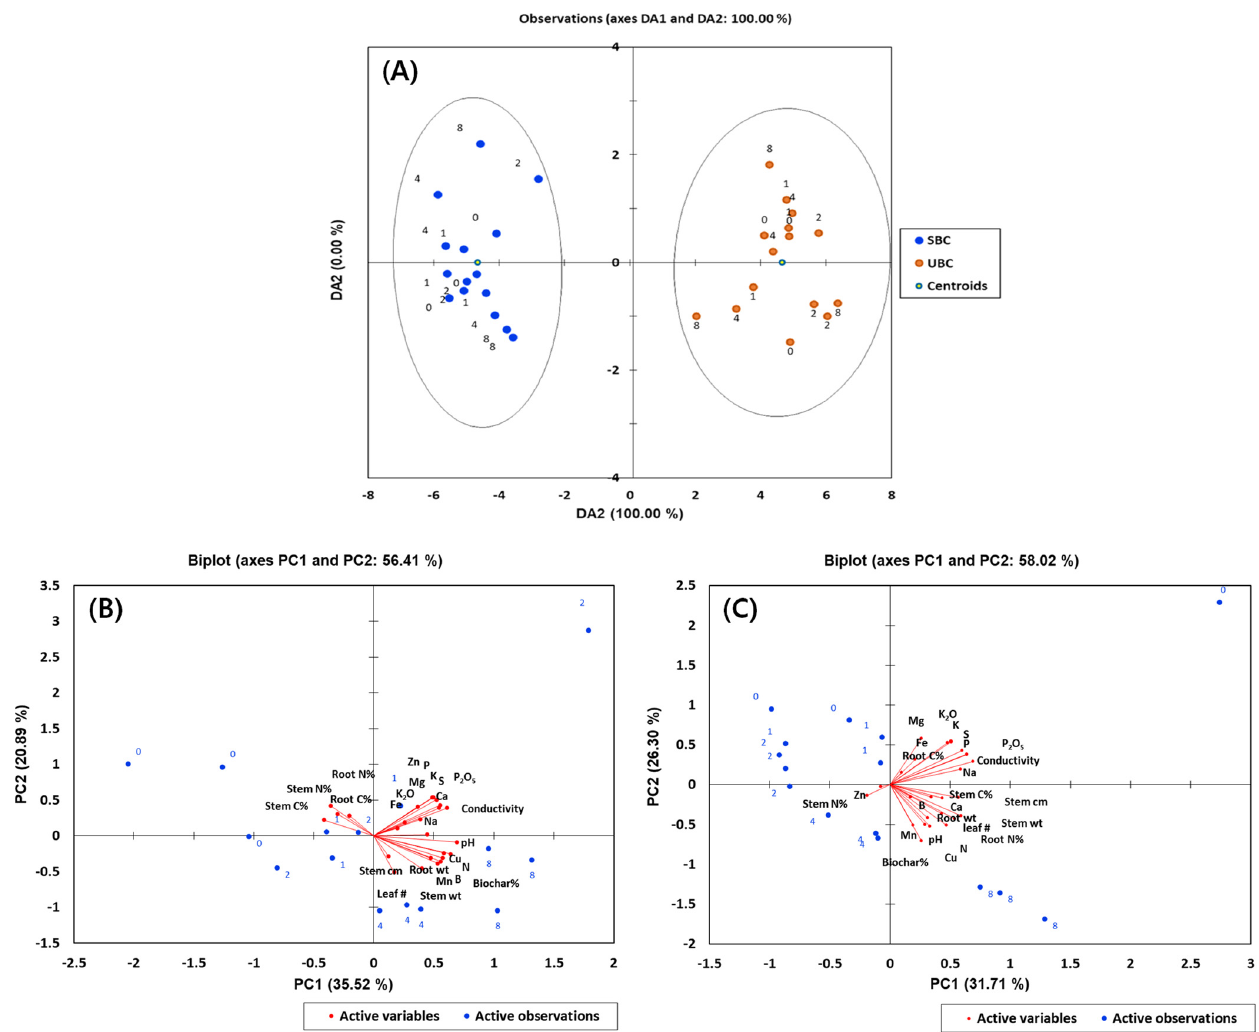
Figure 1. Physicochemical properties of wood biochar (BC) treated soil. Discriminant analysis (DA) among soil treated with SBC and UBC ( A ). Principal component analysis (PCA) of soil properties, plant growth parameters and the loading rates of saturated BC (SBC) in soil ( B ) and unsaturated biochar (UBC) in soil ( C ). Table 1. Characteristics of soil and wood-derived